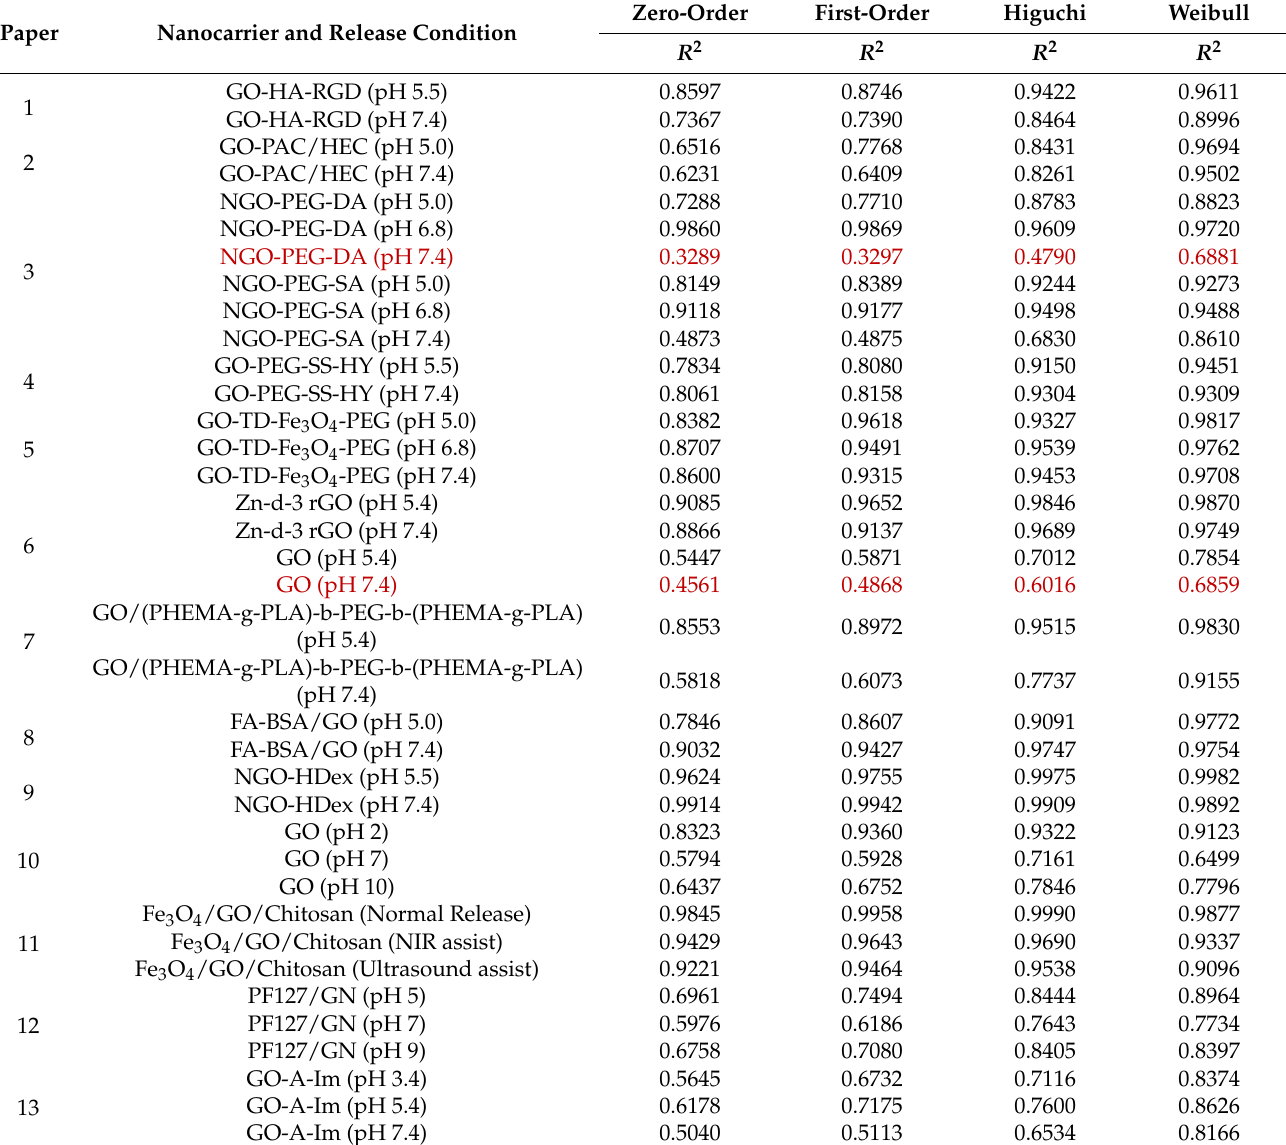
Table 2. The goodness-of-fit parameter R 2 reported for the nanocarrier and different release conditions in each publication for four kinetic